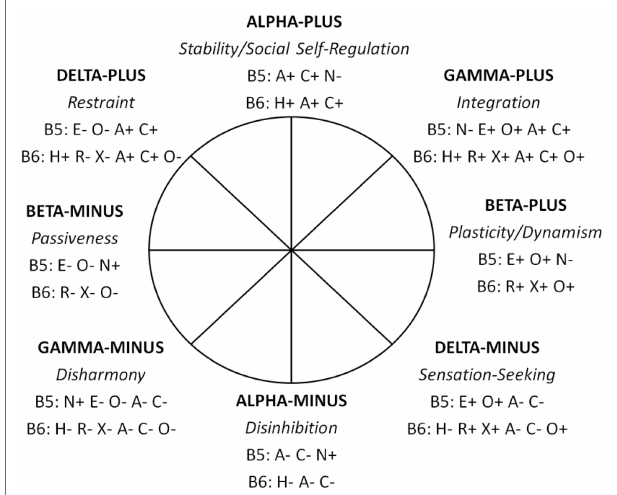
FIGURE 3 | The Big Five and Big Six traits within the modified Circumplex of Personality Metatraits. B5, Big Five traits; N, Neuroticism/Emotional Stability; E, Extraversion; O, Openness to experience/Intellect; A, Agreeableness; C, Conscientiousness; B6, Big Six traits; H, Honesty-Humility/Propriety; R, Resiliency/Emotionality; X, Extraversion; A, Agreeableness; C, Conscientiousness; O, Originality/Openness to experience; + positive pole of the trait; − negative pole of the trait (Strus and Cieciuch,